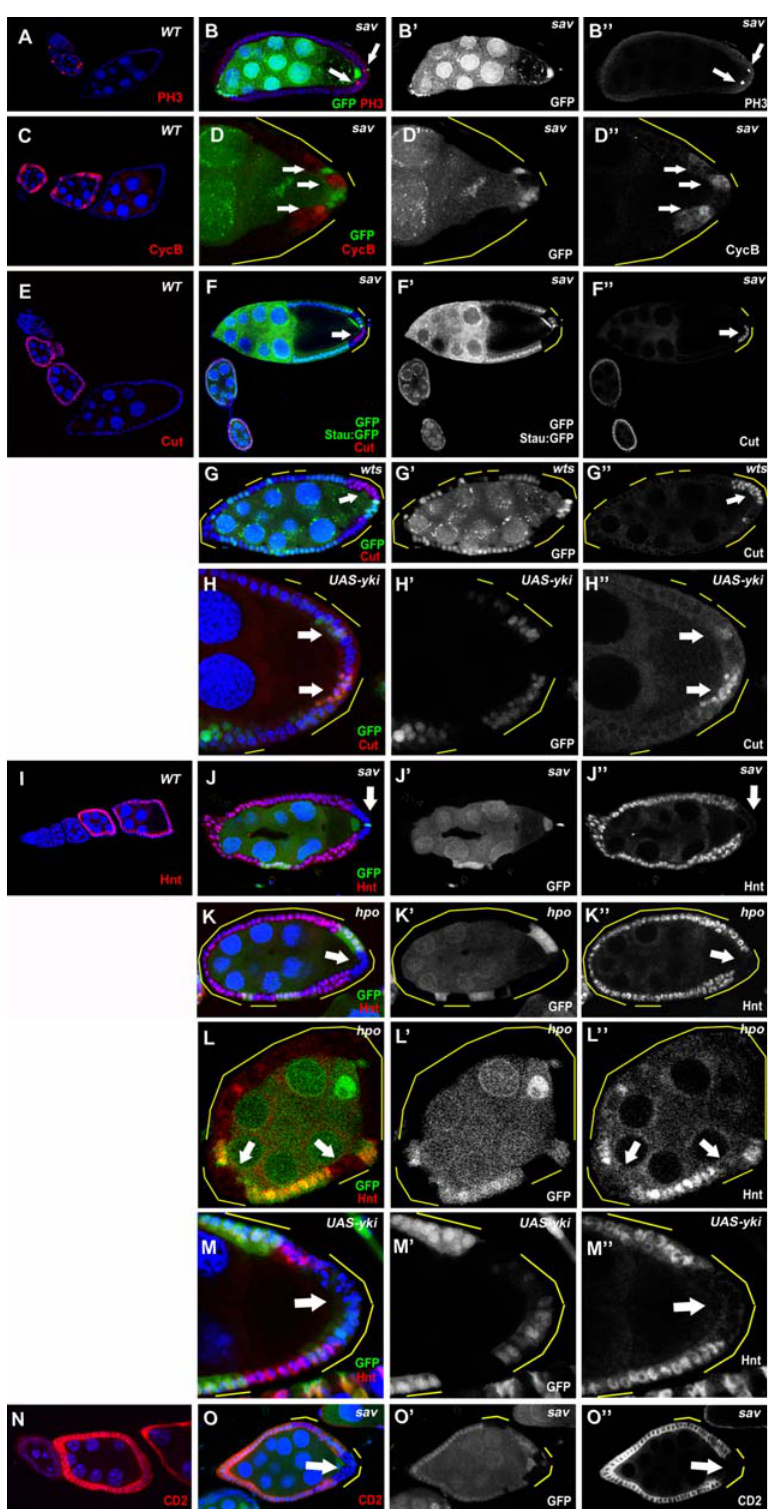
Figure 3. Notch signaling is disrupted in PFC clones of Hpo pathway mutants. (A and C) PH3 and Cyclin B are expressed sporadically in immature follicle cells during early stages (S1–S6) in wild-type egg chambers. In sav mutants, staining of PH3 (B) and Cyclin B (D) was occasionally found in mutant PFC after stage 6 (arrows). (E) In wild-type egg chambers, Cut is expressed in follicle cells until about stage 6. (F and G) Prolonged Cut expression was found in sav (F) and wts (G) PFC clones at stages 8–10 of oogenesis. (I) Hnt is expressed in follicle cells after stage 6 in the wild type. No Hnt expression was found in sav (J) or hpo (K) mutant PFC in stage-8 egg chambers. (L) Lack of Hnt staining was also occasionally observed in anterior and lateral hpo clones in stage 7 egg chambers (arrows). Overexpression of Yki caused prolonged Cut expression (H) and decreased Hnt expression (M). (N) The E(spl):CD2 Notch activity reporter, visualized by CD2 staining, is upregulated in follicle cells during stages 7–10A of oogenesis in wild-type egg chambers. (O) Lack of CD2 staining was observed in sav mutant PFC in this stage-7 egg chamber (arrow). doi:10.1371/journal.pone.0001761.g003 PLoS ONE |